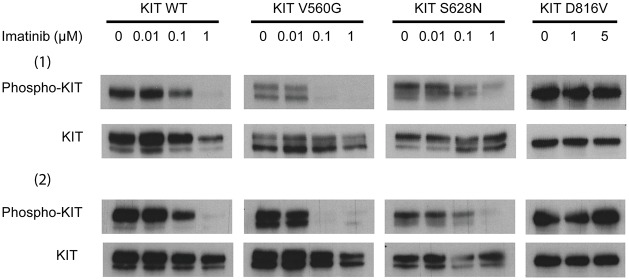
Inhibition of KIT phosphorylation by Imatinib.Cells expressing KITWT, KITD816V, KITV560G or KITS628N were treated with the indicated concentrations of Imatinib for 90 minutes. Protein lysates were analyzed by western-blotting to reveal KIT protein expression (KIT) and KIT phosphorylation (Phospho-KIT) as readout of Imatinib inhibition. Two independent experiments were performed.